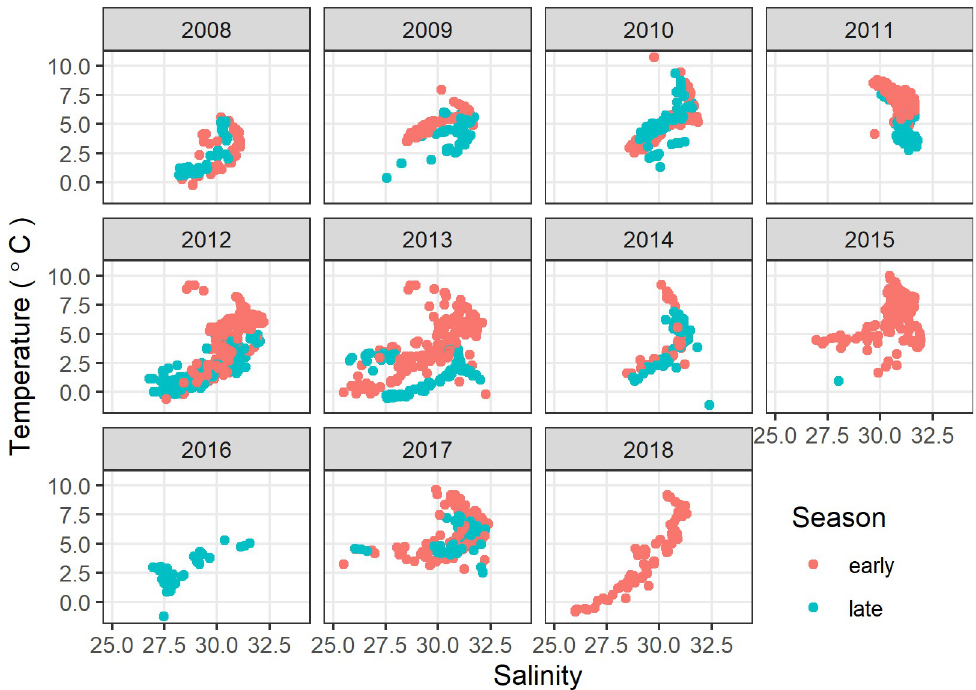
Fig 4. Temperature and salinity of water in upper 10 m of water column, northeastern Chukchi Sea. Early summer was 13 Aug–6 September and late summer was 7 September–2